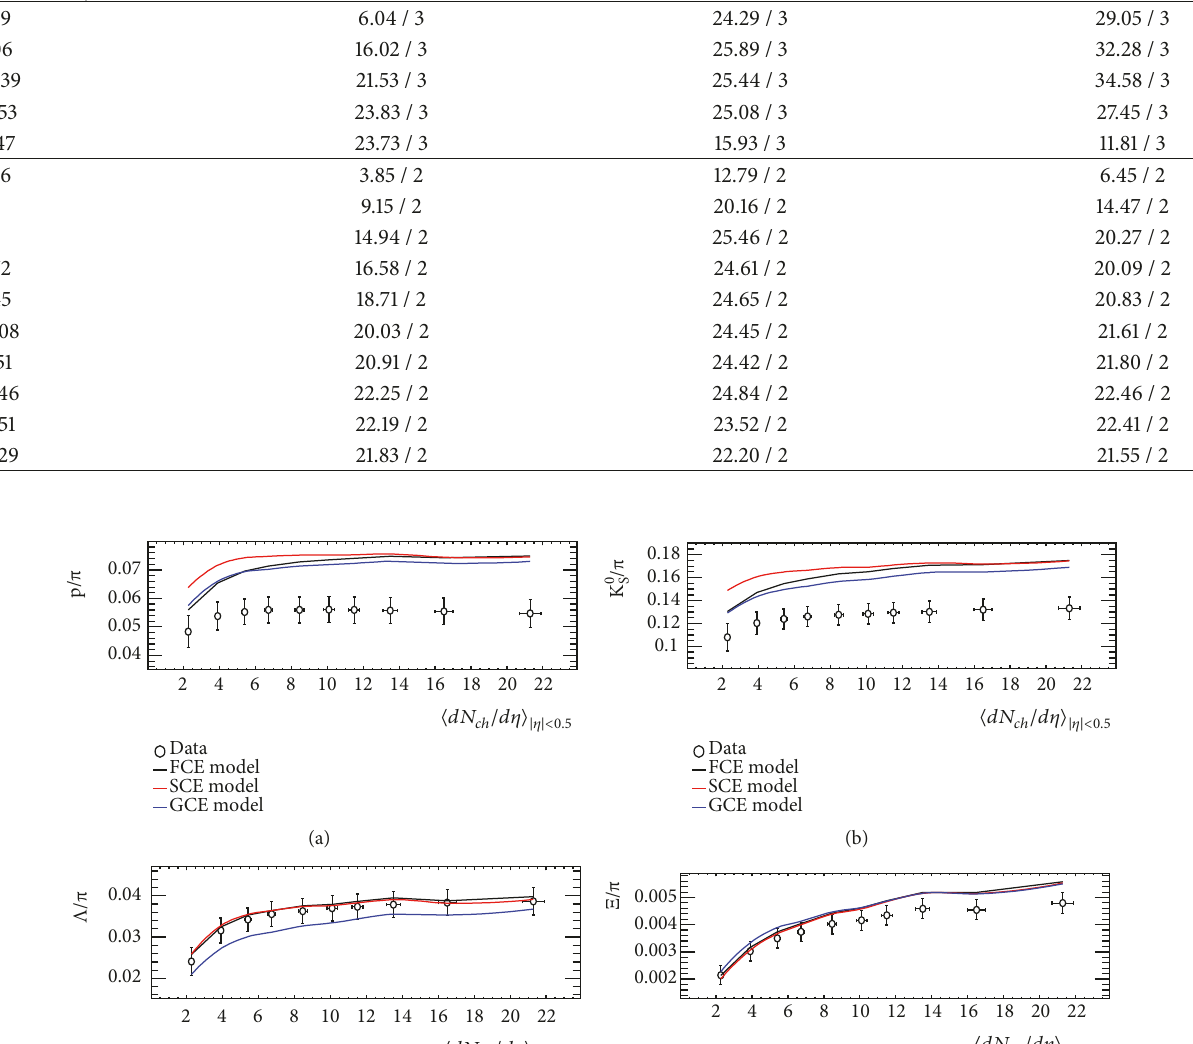
Table 2: Values of 𝜒 2 /ndf for various fits. The values in the top (bottom) part include (exclude) the Ω yields in the fits. ⟨𝑑𝑁 /𝑑𝜂⟩| 𝑐ℎ |𝜂|<0.5